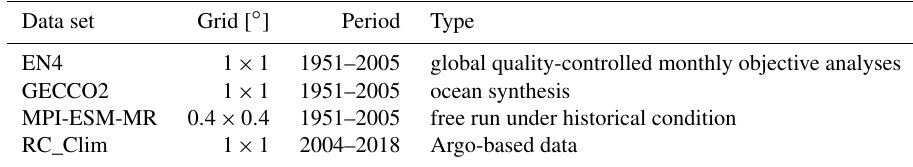
Table 1. Summary of data